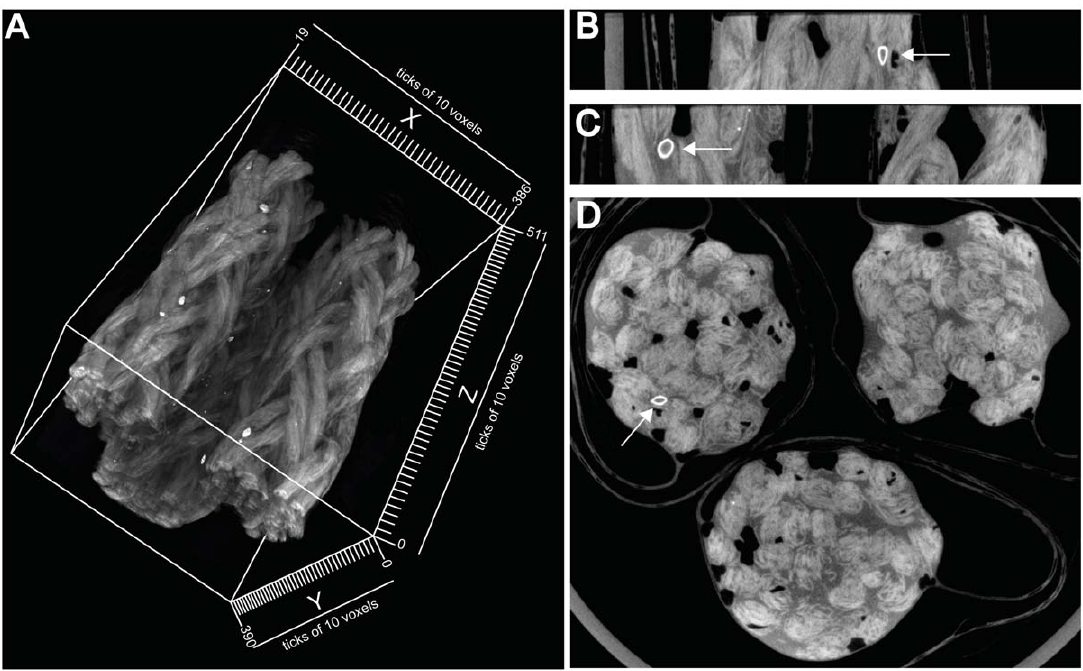
Figure 1. Three-dimensional tomogram of rope samples collected 17 days post settlement. (A) Tomogram with a reduced volume of 512 3 voxels and a voxel size of 78 m m for visualising purposes. (B) Micro spatial scale settlement of a mussel in x-plane, (C) y-plane, and (D) z-plane. Arrows indicate a mussel, which is clearly distinguishable by the oval shape with a hollow centre, which characterises the two shell valves. Tomograms with 1024 3 voxels were generated and used for analysis with a voxel size of approximately 39 m m.